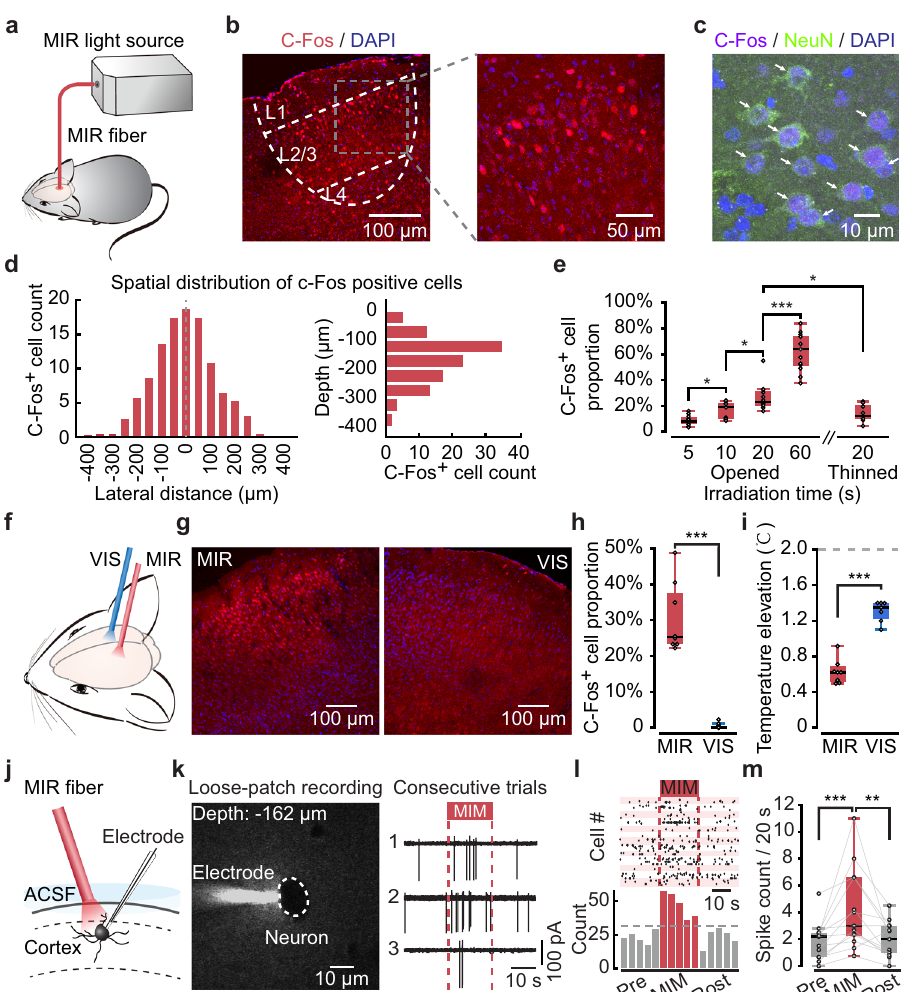
Fig. 1 MIM application to the mouse cortex induces neuronal activities. a General scheme for targeted MIR delivery to mouse brain in vivo. b Left image: a confocal image of a postmortem slice near the MIR target spot. Right image: magni fi ed view of the left image (gray dashed box). White dashed lines: outlining the cortical layers and the central zone of c-Fos + expression, a commonly used marker of neuronal activation. c Control experiment with co- labeling of c-Fos and NeuN. White arrows: cells positive with both c-Fos and NeuN. d Histograms of the lateral (left) and transverse (right) distributions of c-Fos + cells; data points are pooled from 7 mice. See Methods for de fi nition of cell counts. e C-Fos + cell count in slice samples taken from different groups of mice ( n = 4) performed with different MIR irradiation time and conditions (through opened skull or thinned intact skull). P = 0.012 (Opened 5 s versus 10 s), P = 0.039 (Opened 10 s versus 20 s), P = 8.0054e − 05 (Opened 20 s versus 60 s), P = 0.0121 (Opened 20 s versus Thinned 20 s), two-sided Wilcoxon rank-sum test, n.s. P > 0.05, * P < 0.05, ** P < 0.01, *** P < 0.001, applies for all panels in this fi gure. f Schematic showing the MIR-VIS control experimental design. g Fluorescence images of slices taken at the MIR target spot (left) or the VIS target spot (right), both images taken from the same animal. h Boxplots showing the c-Fos + cell count in the MIR- or VIS-exposed regions taken from the same 4 mice (8 slices taken for the MIR group, 13 slices taken for the VIS group, P = 1.0157e − 04, two-sided Wilcoxon rank-sum test). i Local cortical tissue temperature elevation ( n = 7 mice) at the site closest to the fi ber tip, measured by a miniature thermocouple probe under MIR or VIS irradiation. Dashed line indicates 2 °C, below which light stimulation has previously been shown to not change or even suppress neuronal activities ( P = 5.8275e − 04, two-sided Wilcoxon rank-sum test). j Schematic for single-cell loose-patch recording simultaneously with MIM application in vivo. k Left image: the patch electrode and target cell under live two-photon imaging navigation in vivo. Right traces: three consecutive trials of loose-patch recording from one example neuron. l Upper raster plot: pooled single-trial spiking data from all 13 recorded neurons. Lower histogram: summary of spike count. m Boxplots summarizing 13 recorded neurons, showing spike count before ( “ Pre ” ), during (MIM) and after ( “ Post ” ) MIM application. P = 2.4414e − 04 (Pre versus MIM), P = 0.0054 (MIM versus Post), two-sided Wilcoxon signed-rank test. The box-and-whisker plots indicate the median (central mark), 25th and 75th percentiles (bounds of box: Q1 and Q3), interquartile range (IQR: Q3 – Q1), and the whiskers extending to the minima and maxima without considering